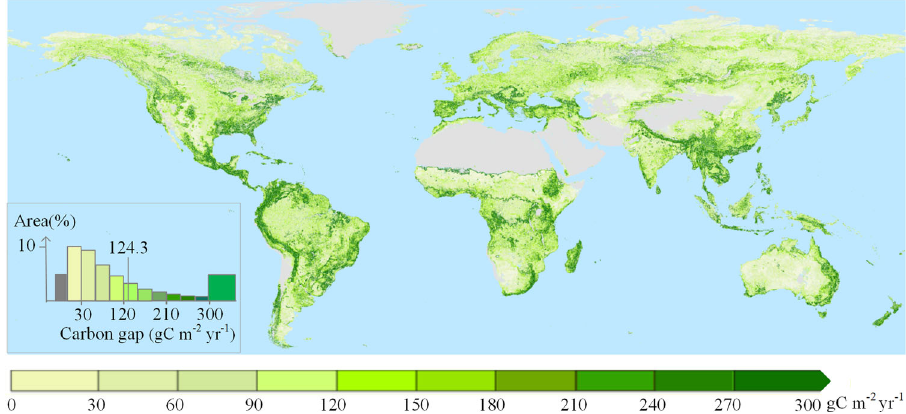
Fig. 1 Distribution of global carbon gap density ( fl ux). The density is depicted through pixel values at 500 m × 500 m spatial resolution. The inset fi gure shows the histogram of area percentage in each of the bins of the carbon gap density. The most left gray bar indicates that these areas ( = 4.8% out of all vegetated areas which is 110.5 × 10 6 km 2 ) have carbon gap = 0 (where NPP CR ≥ NPP CR 90th ), indicating LMPs already being OLMPs). The most right green bar, which also happens in about 4.8% of the total vegetated area, represents that those locations have the most highest carbon gap density (>300 gC m − 2 yr − 1 ). The vertical line in the inset histogram shows the location of the averaged carbon gap density (i.e., 124.3 gC m − 2 yr − 1 ) over the whole area of the 12 continents/regions (North America, Central America, South America, Europe, Africa, Australia, East Asia, North Asia, South Asia, Southeast Asia, Southwest Asia, and Central Asia). A total of more 13.74 PgC yr − 1 is expected to be sequestered from vegetation if OLMPs are implemented at a global scale.